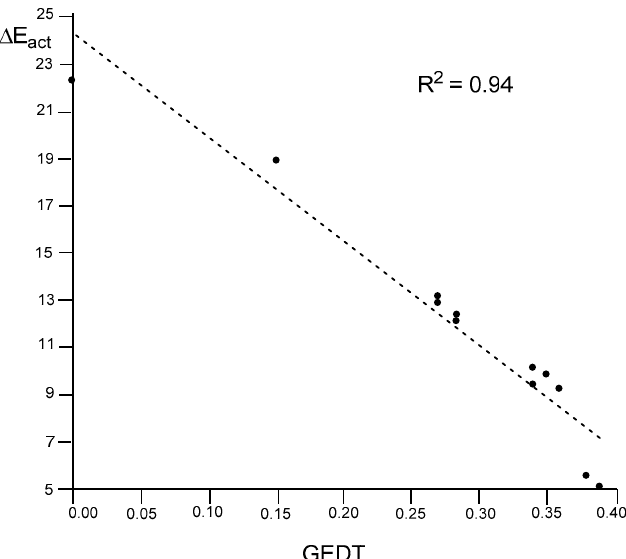
Figure 6. Plot of the activation energies, ∆ E act , in kcal · mol − 1 , of the DA reactions between Cp 1 and the series of LA complexes vs. the GEDT, in average number of electrons, e, computed at the corresponding endo and exo TSs. The values corresponding to the DA reactions of Cp 1 with ethylene 5 and with acrolein 7 are also included.